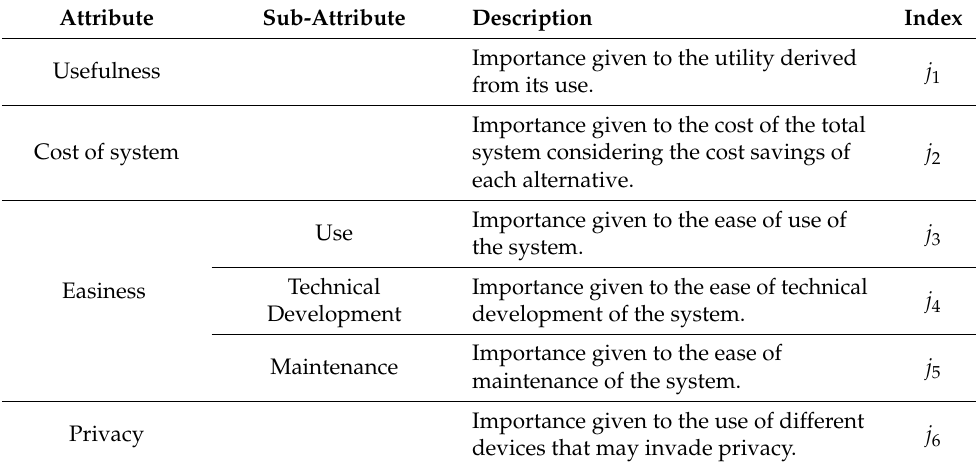
Table 7. Attribute list.